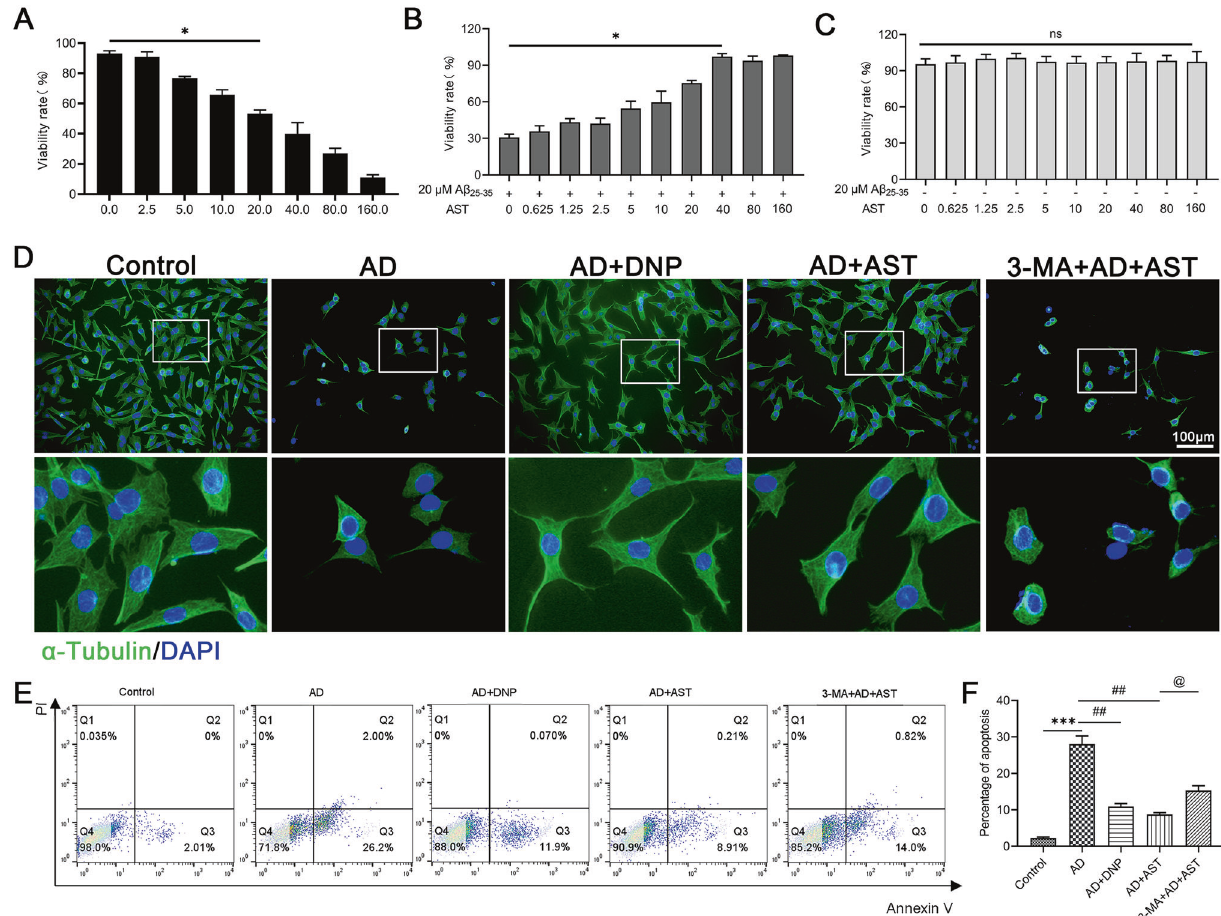
Fig. 6 Effects of AST on the proliferation and apoptosis of A β 25-35-damaged HT22 cells. A Cell viability was detected in HT22 cells with different concentrations of A β 25-35 (0 – 160 μ M A β 25-35, 24 h) by CCK8 assay. B Cell viability was detected in A β 25-35-injured HT22 cells (20 μ M A β 25-35, 24 h) with different concentrations of AST (4 h before A β 25-35 treatment) by CCK8 assay. C Cell viability was detected in HT22 cells with different concentrations of AST (0 – 160 μ M AST, 24 h) by CCK8 assay. Data were presented as mean ± SD, * p < 0.05 vs 0 μ M . D Effect of AST on the morphological alteration of HT22 cells was observed by immuno fl uorescent staining. E , F Flow cytometry analysis indicated the anti- apoptotic effect of AST on the apoptosis of HT22 cells. Data were presented as mean ± SD, n = 3/group. *** p < 0.001 vs control group, ## p < 0.01 vs AD group, @ p < 0.05 vs AST + AD